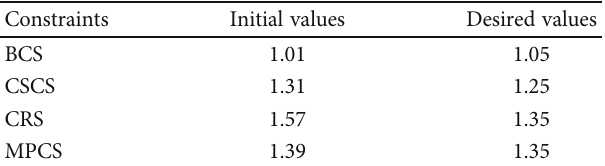
Table 2: Design constraints.